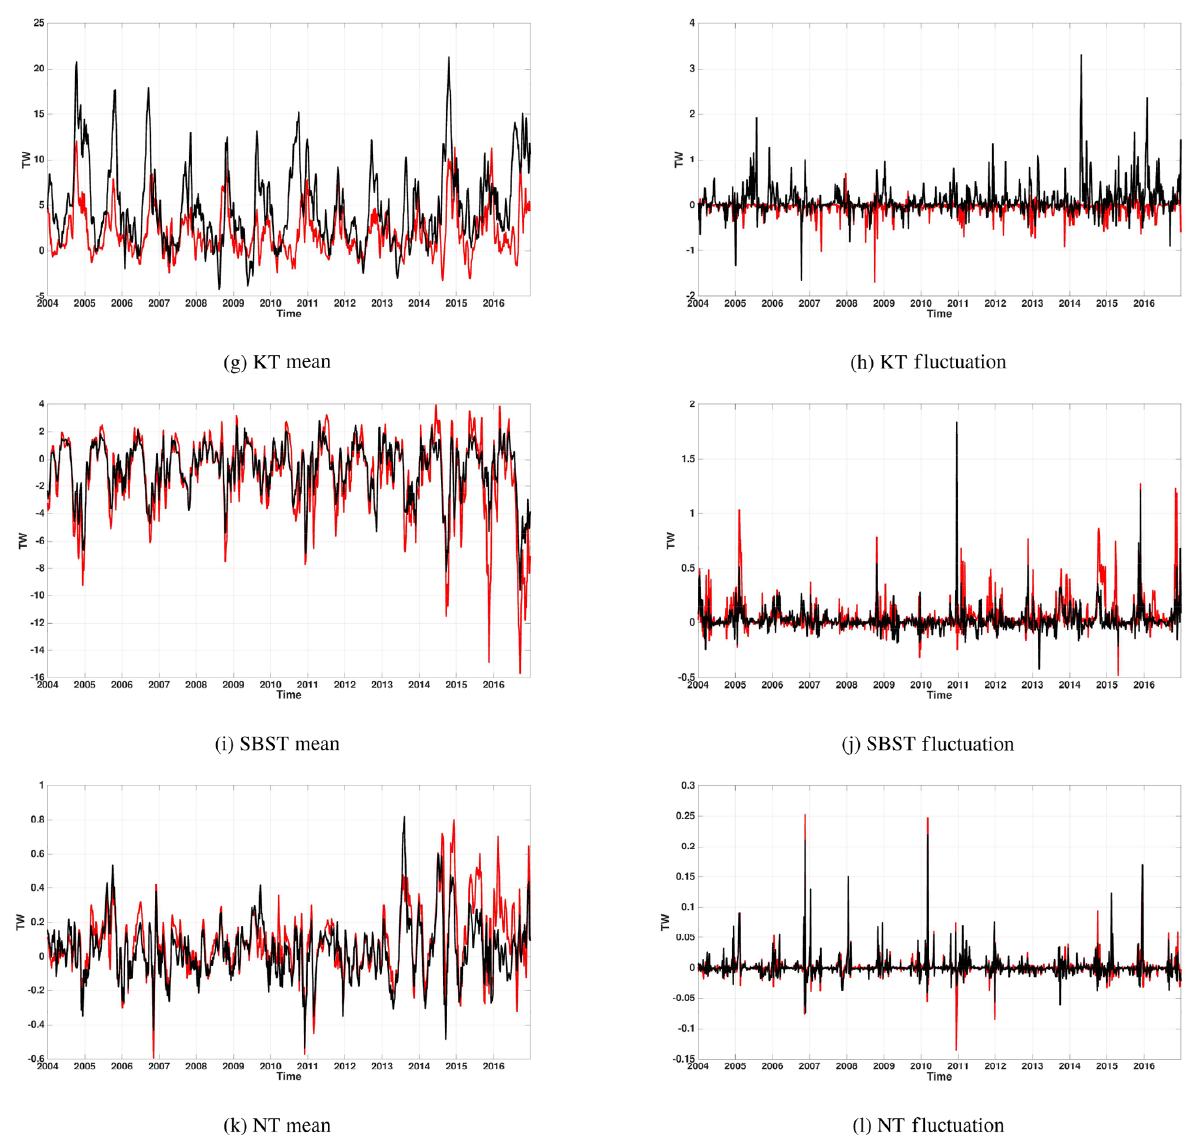
Figure 11. Mean (left column) and fluctuating (right column) components of the heat flux (TW) from LowResControl (in red) and HighRes (in black). Plotted for the whole time series 2004 to 2016. Each row is for a different trough.